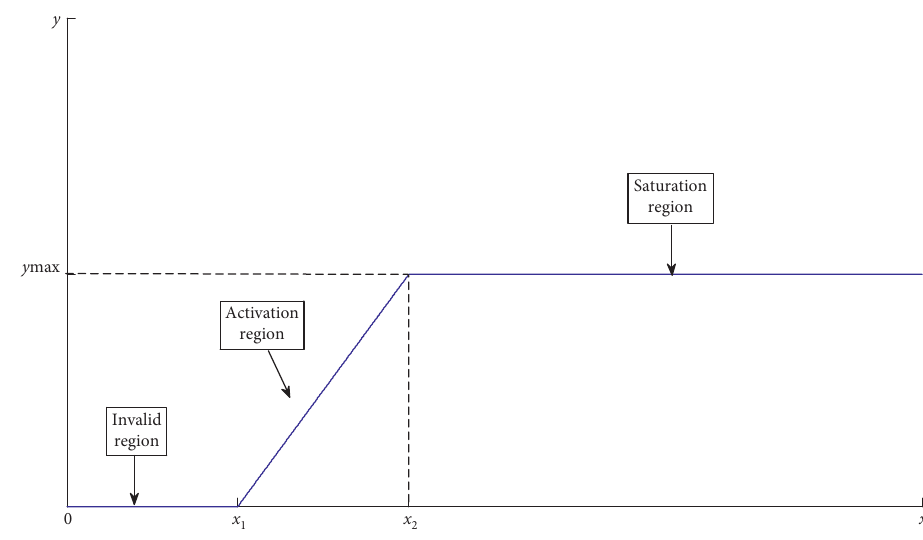
Figure 3: Charging behavior change (power transfer probability)